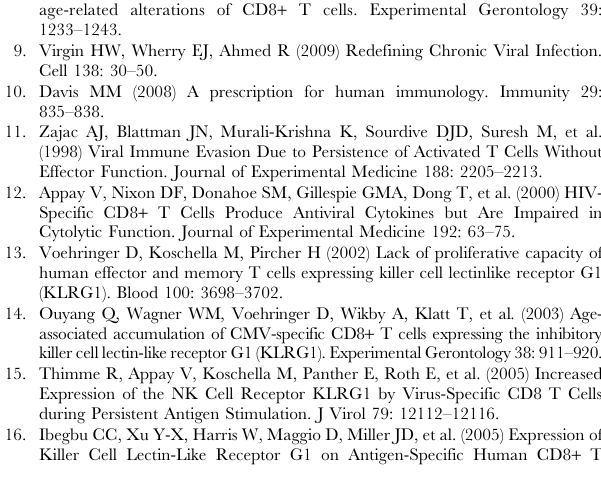
Figure S1 PD-1 expression is elevated in both influenza- specific and total CD8 T cells from older individuals . PD- 1 levels were measured by flow cytometry direct ex vivo in conjunction with tetramer staining for HLA–A2 positive young and older donors. Left: Median fluorescence intensity (MFI) of PD- 1 in influenza M1-specific CD8 T cells. Right: Representative PD-1 expression in tetramer + and total CD8 T cells compared to FMO control (shaded) in under 40 and 65 +